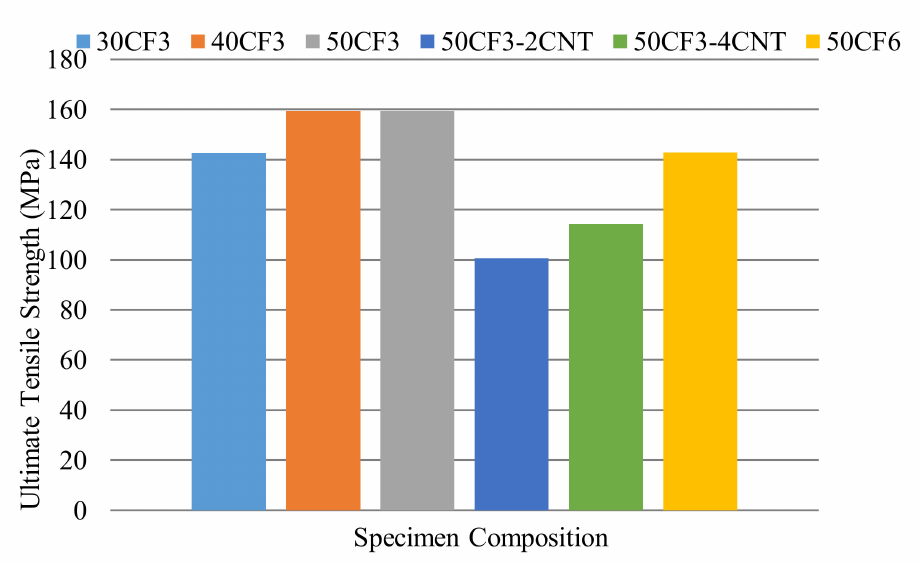
Figure 8. Average ultimate tensile strength for di ff erent specimen compositions.